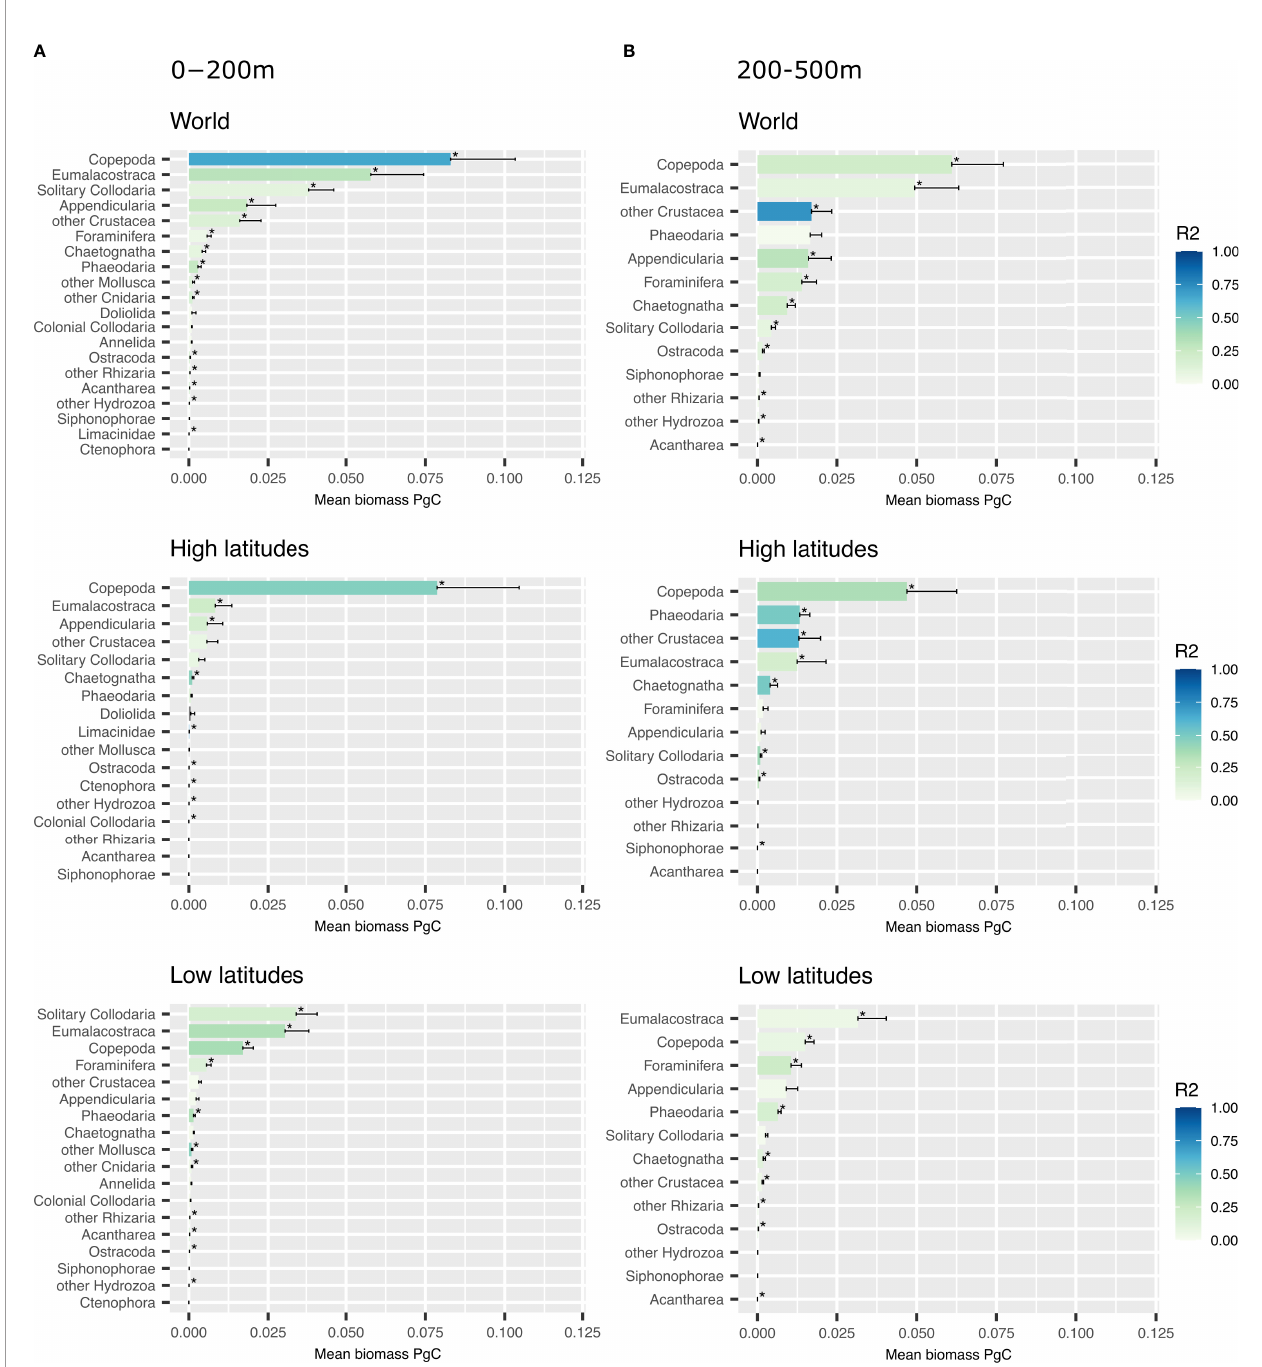
FIGURE 4 | Barplots showing the mean biomass predicted in PgC at 0-200 m (A) and 200-500 m (B) depth for each group ranked from highest to lowest biomass in 3 types of models: world, outside 40°N-40°S and inside 40°N-40°S. Error bars correspond to upper interval of the biomass estimation ’ s standard deviation. The stars indicate a signi fi cant result (p-value < 0.05) obtained with the Pearson correlation